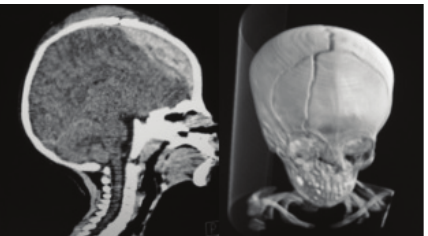
Figure 2: Sagittal and 3D CT scan images showing VEDH and frontal paramedian fracture extending down to the right orbital